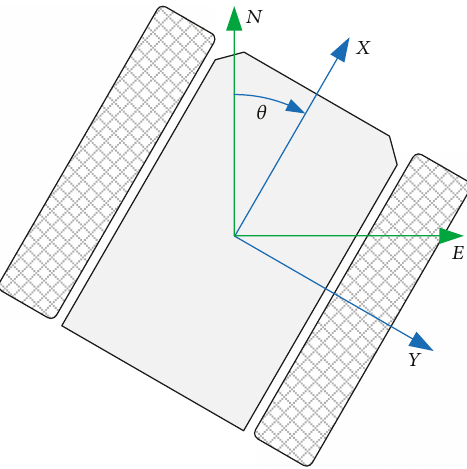
Figure 2: Coordinate systems on a tracked robot. The blue axes represent the body coordinate system, and the green ones represent the world coordinate